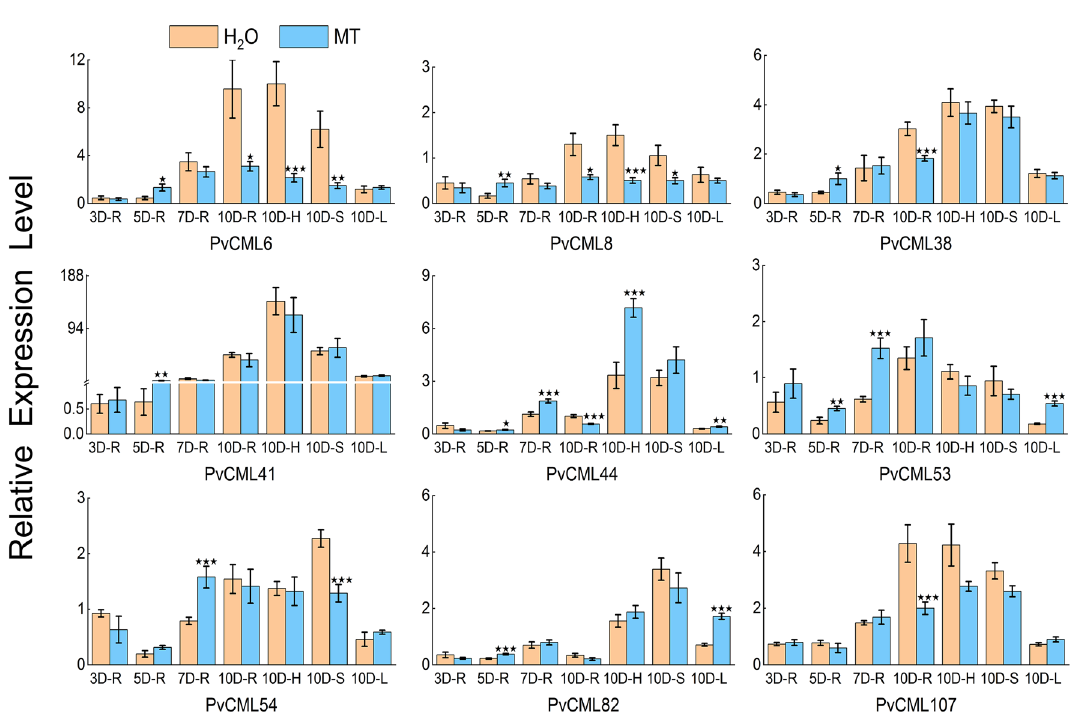
Figure 7. The qRT-PCR expression patterns of CML genes in P. vulgaris. The reactions were normalized using the actin reference gene. The standard deviations were represented by the error bars from three independent technical replicates. 3 Day-Root (3D-R), 5 Day-Root (5D-R), 7 Day-Root (7D-R), 10 Day-Root (10D-R), 10 Day-Hypocotyl (1D-H), 10 Day-Stems (1D-S) and 10 Day-Leaf (1D-L). The expression levels of each gene were expressed as a ratio relative to that of 3D-R (H 2 O). t -test was used to analyze the mean expression levels of three replicates in melatonin treatment (MT) with control treatment (H 2 O). Star(s) above the bars indicated significant differences among the treatments. A star represented significant level ( p < 0.05), two stars represented significant level ( p < 0.01), and three stars represented significant level ( p <